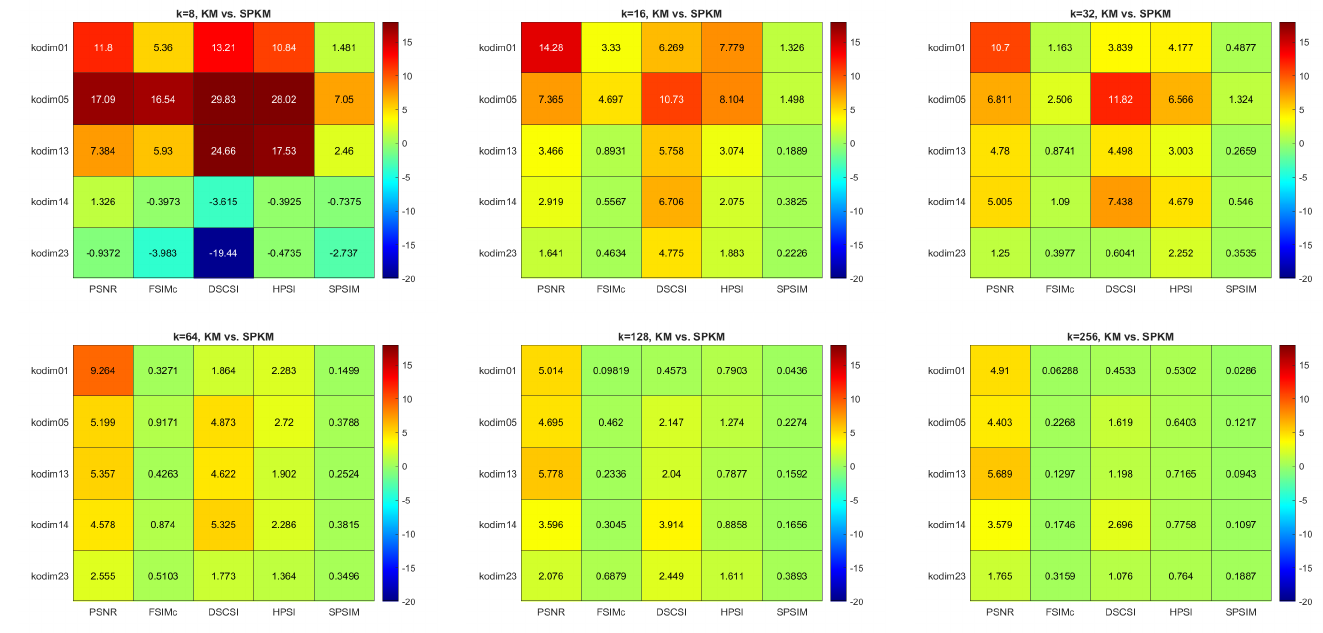
Figure 5. Multi − index quality assessment of quantized images: KM versus